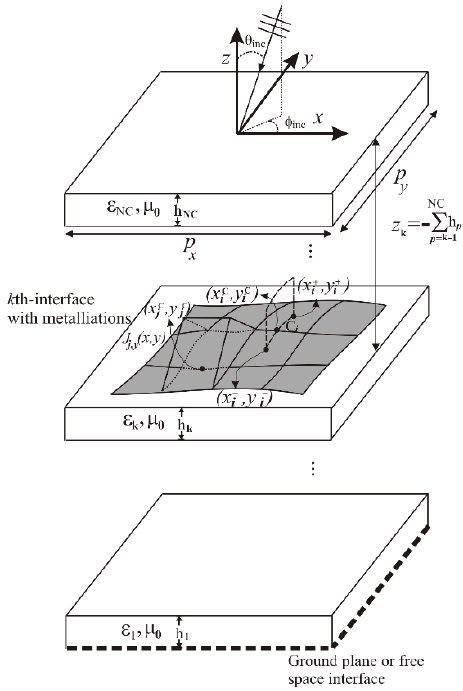
Figure 1. Unit cell of p x × p y size of a multilayer periodic structure with NC dielectric layers. k th interface hosts planar generic layout. Bézier patches’ discretization of the surface of the planar layout is shown. On this interface, generalized rooftops and razor blade defined on a pair of adjacent Bézier patches are shown.